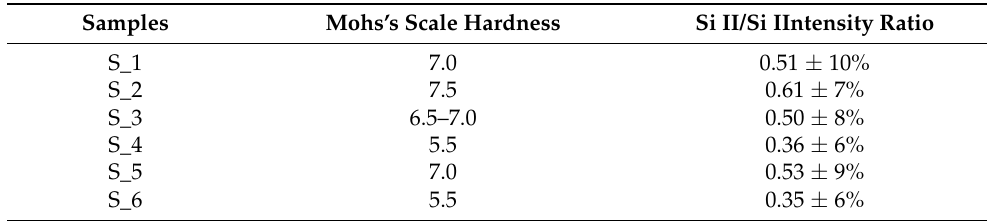
Table 6. Mohs’s scale hardness and LIBS SiII/SiI intensity ratio for all the gemstone samples.